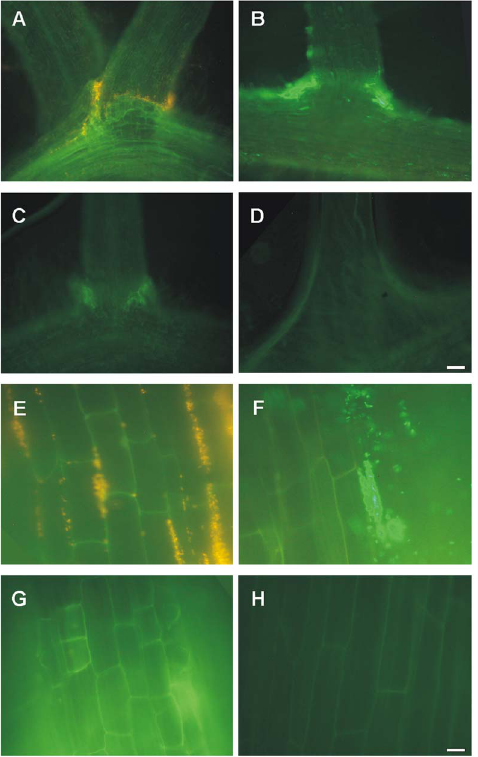
Figure 1. Representative fluorescence photomicrographs of E. coli K12-colonized lettuce roots. (A–D) Detail of E. coli localization to zones of lateral root emergence or (E–H) root elongation zone after inoculating seedlings with (A and E) RFP-, (B and F) GFP-, (C and G) non- labeled cells or (D and H) non-inoculated seedlings. Magnifications were at (A–D) 150X or (E–H) 750X. The white bar corresponds to 20 m m (A–D) or 10 m m (E–H).